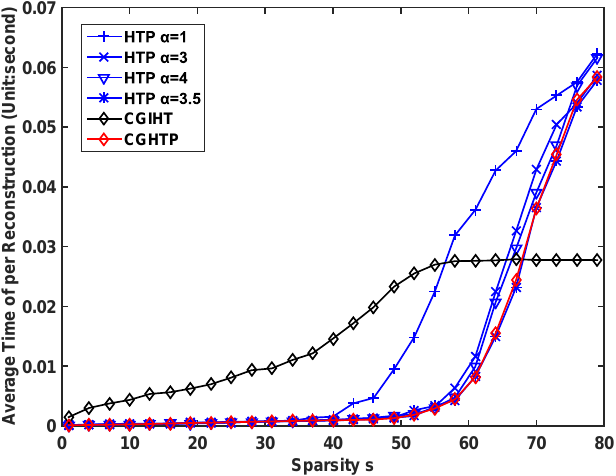
Figure 5. Time consumed by HTP with different step size, CGIHT, and CGHTP